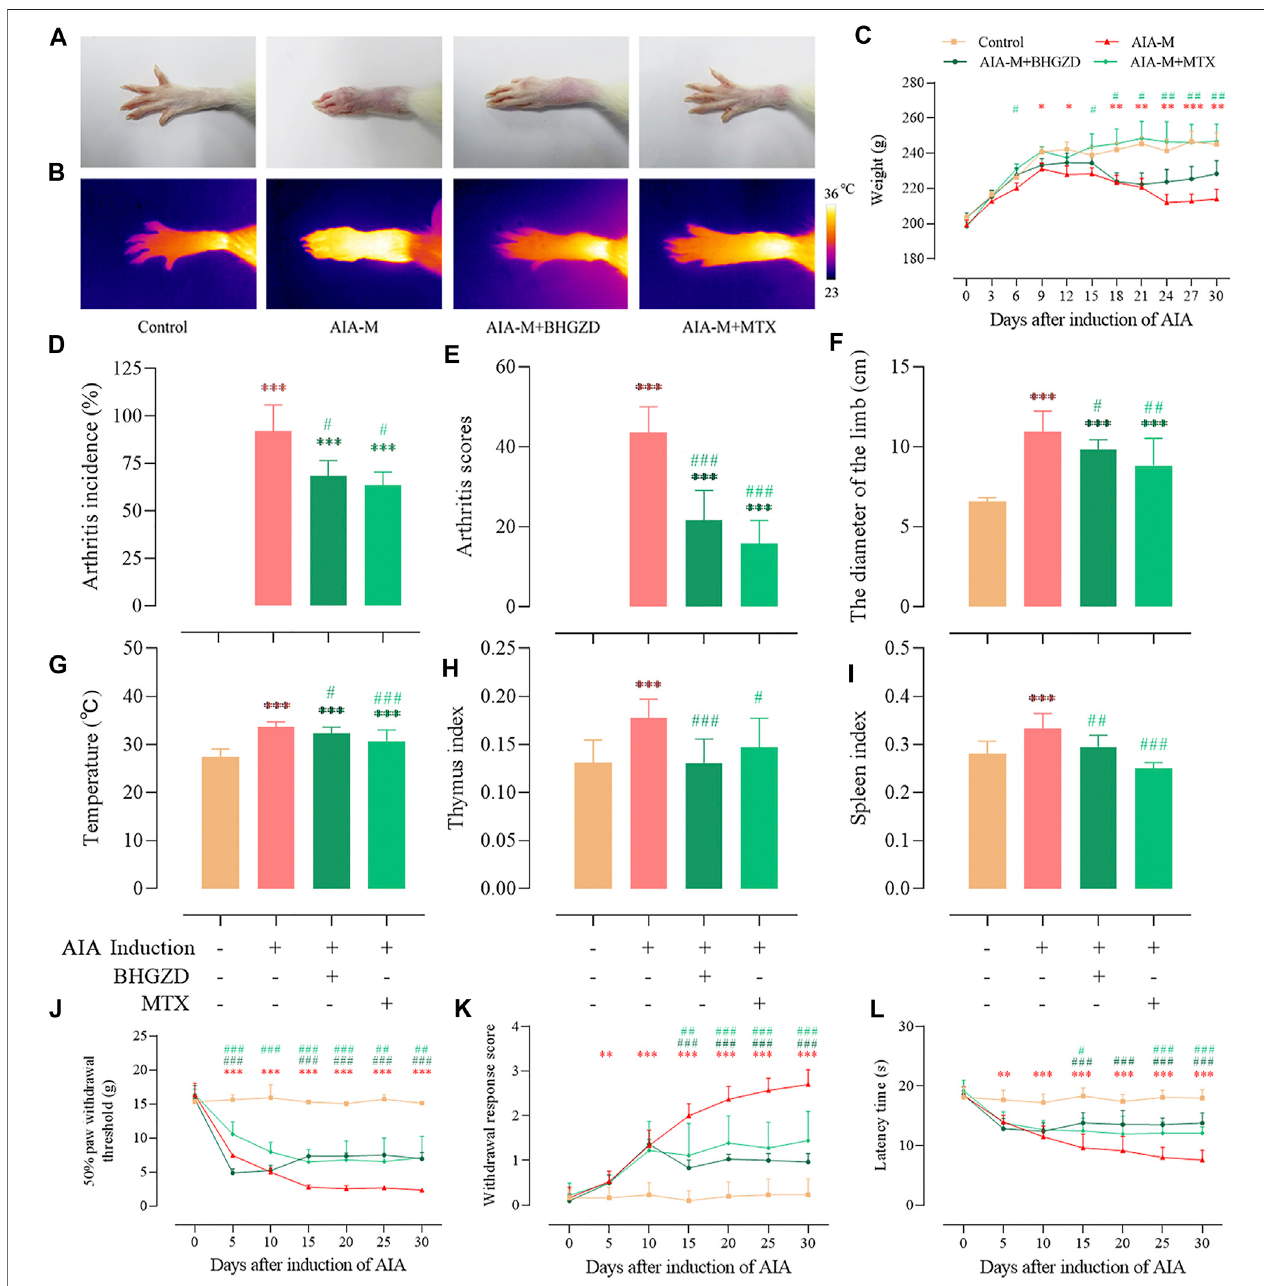
FIGURE 1 | Effects of BHGZD on the severity of arthritis in AIA-M rats of different groups. (A) Macroscopic performances of arthritis; (B) infrared thermography; (C) weight; (D) arthritis incidence; (E) arthritis scores; (F) the diameter ofthe limb; (G) articular temperature; (H) the thymus index; (I) the spleen index; (J) mechanically induced hyperalgesia; (K) acetone-induced hyperalgesia; (L) thermally induced hyperalgesia.Dataareexpressedasthemean ± S.D.*,**, and ***, p < 0.05, p < 0.01,and p < 0.001, respectively, in comparison with the normal control group; #, ##, and ###, p < 0.05, p < 0.01, and p < 0.001, respectively, in comparison with the AIA-M group.